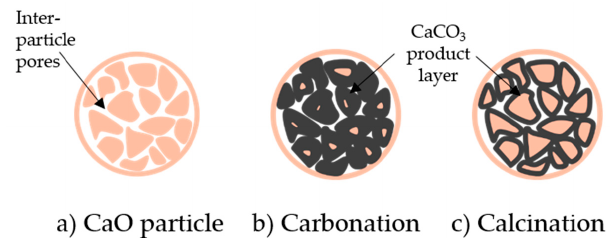
Figure 10. Schematic representation of a CaO particle undergoing carbonation-calcination cycling reactions.